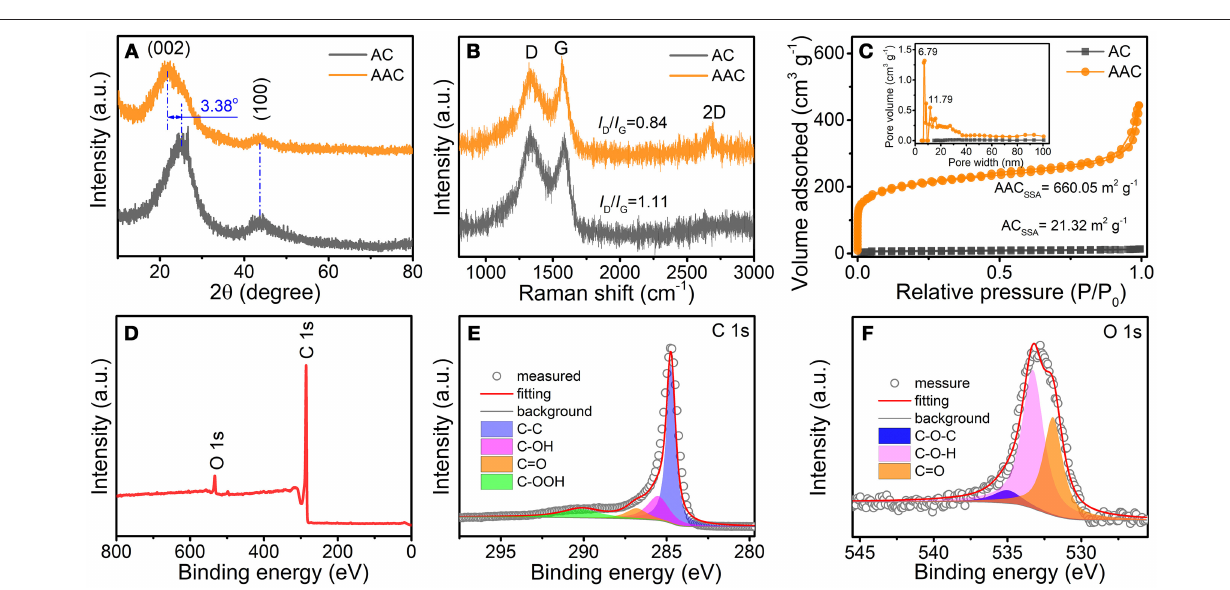
as C-C (284.78 eV), C-OH (285.48 eV), C = O (286.88 eV), and C-OOH (290.08 eV) in deconvoluted C 1s spectrum.